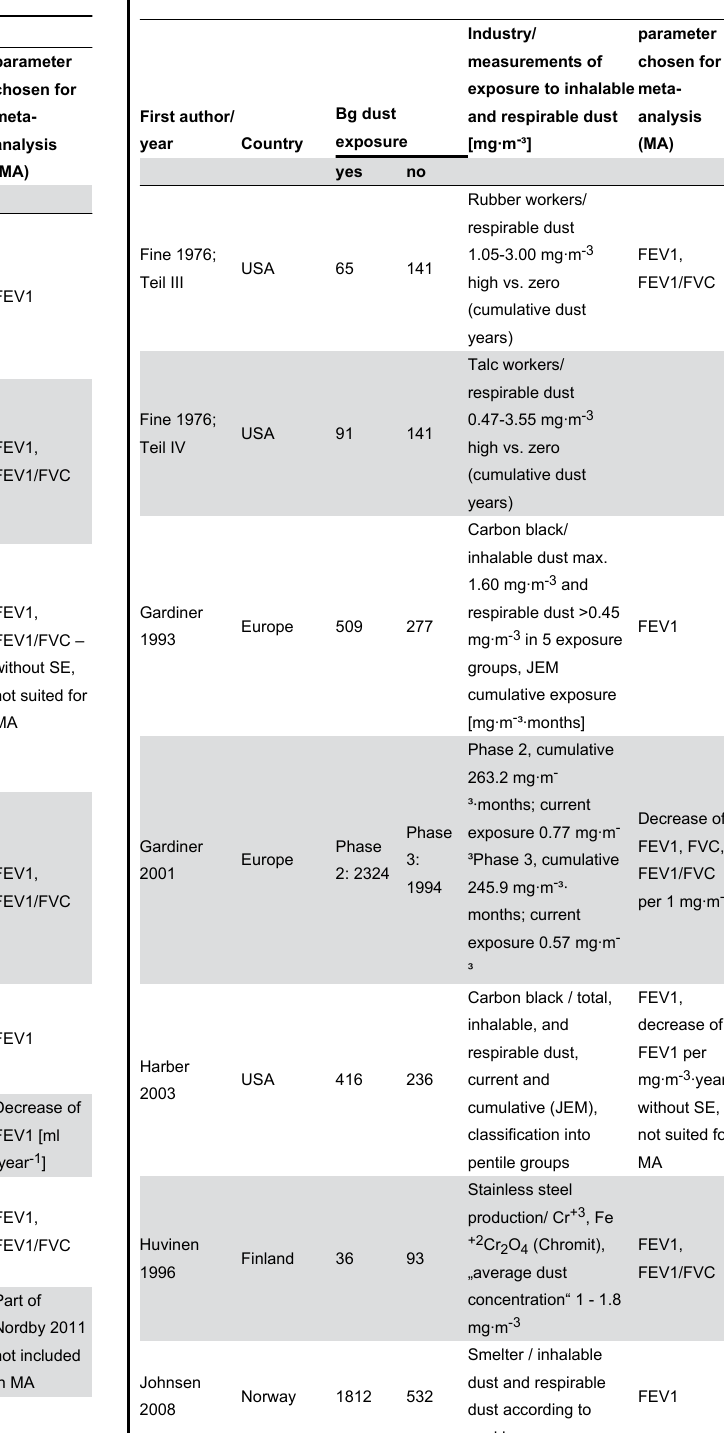
Table 1. Review of the 27 selected studies on biopersistent granular dust and airway obstruction by first author